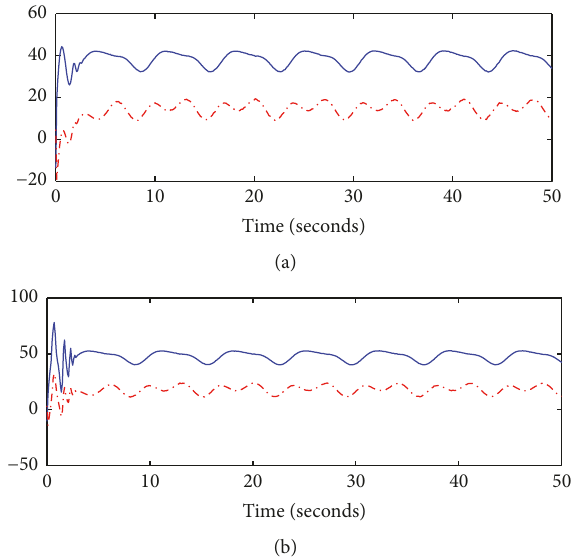
Figure 15: Control input responses: 𝜏 1 (—), 𝜏 2 (- ⋅ - ⋅ ): (a) neural learning control and (b)